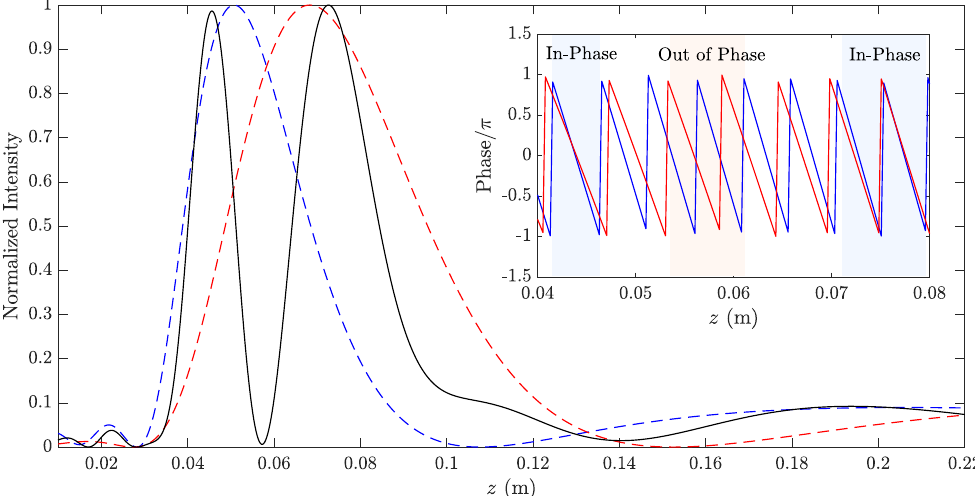
Figure 2. The bi-Fresnel zone plate focusing profile (black) compared to the inner (blue) and outer (red) focusing profiles. The phase of the inner (blue) and outer (red) profiles are shown in the